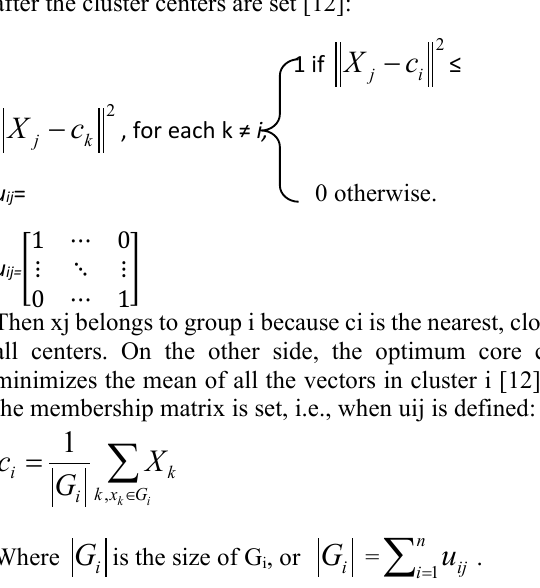
Table 7. URLs assigning for binary code for finding an association between requests